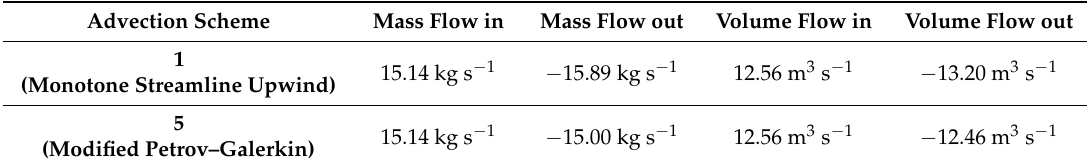
Table 4. Results obtained with the use of the advection schemes 1 and 5 in terms of mass flow balance and volume flow